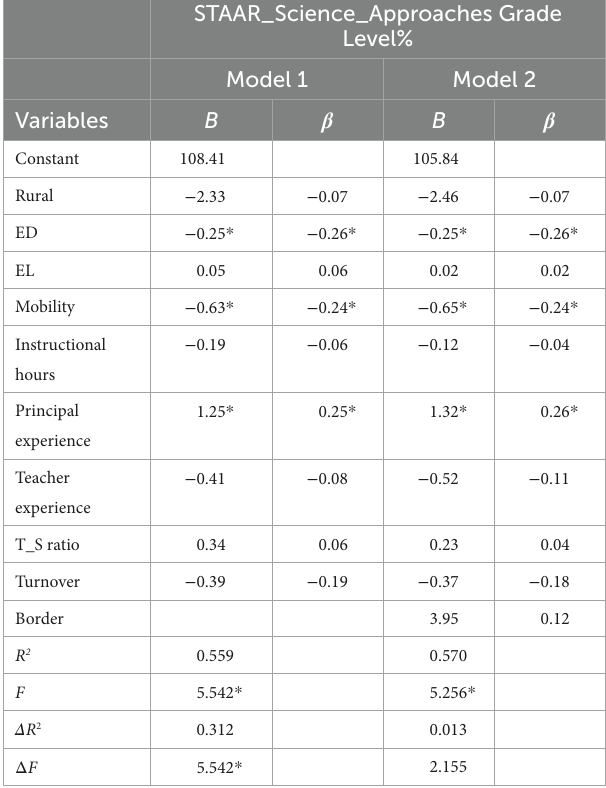
TABLE 4 Hierarchical multiple regression predicting student reading achievement from demographic characteristics and border